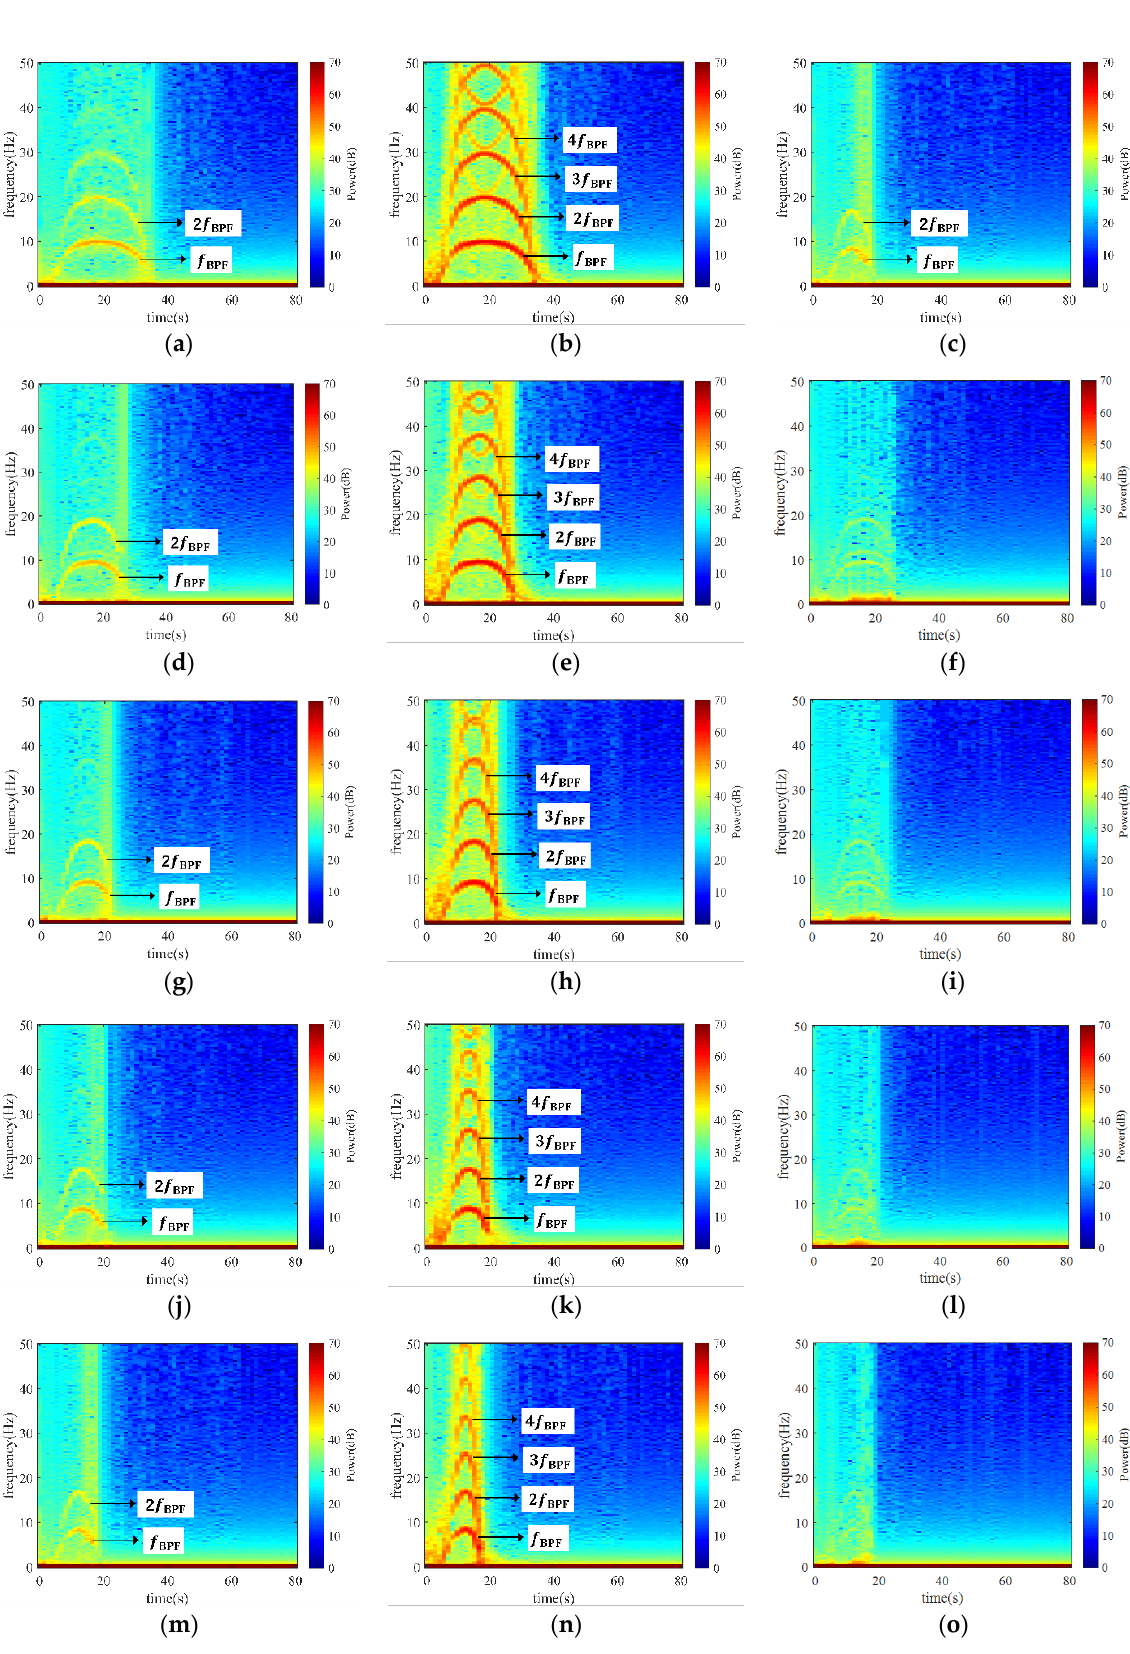
Figure 12. STFT of pressure at the three monitoring points in the five cases. ( a ) Point 1 of Case 1; ( b ) Point 2 of Case 1; ( c ) Point 3 of Case 1; ( d ) Point 1 of Case 2; ( e ) Point 2 of Case 2; ( f ) Point 3 of Case 2; ( g ) Point 1 of Case 3; ( h ) Point 2 of Case 3; ( i ) Point 3 of Case 3; ( j ) Point 1 of Case 4; ( k ) Point 2 of Case 4; ( l ) Point 3 of Case 4; ( m ) Point 1 of Case 5; ( n ) Point 2 of Case 5; ( o ) Point 3 of Case 5.